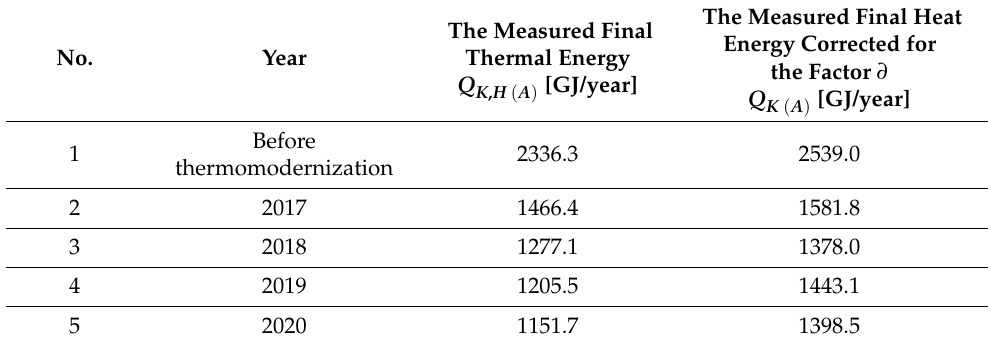
Table 8. Annual final thermal energy consumption in the tested building, measured before and after thermomodernization in 2017–2020 and converted to standard seasonal conditions.